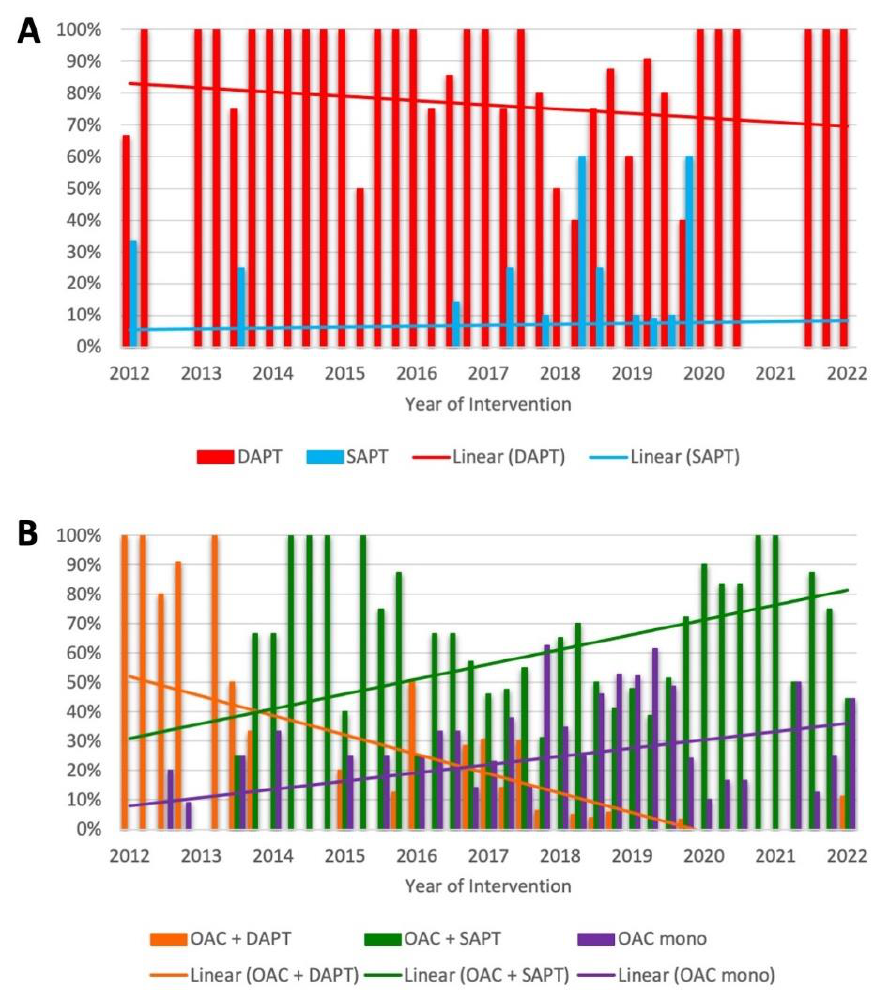
Figure 3. Trends in postprocedural antithrombotic regimens during the study period in patients without (A) and with (B) an indication for oral anticoagulation. ( A ) Quarterly plot with linear trend line of postprocedural prescription of single antiplatelet therapy (SAPT, blue) and dual antiplatelet therapy (DAPT, red). The percentages refer to all patients without indication for oral anticoagulation (OAC, 160/609). Comparison of prescriptions in first and second half of the study period: SAPT: 7.1% vs. 14.5%, p = 0.1; DAPT: 86.9% vs. 77.6%, p = 0.1. ( B ) Quarterly plot with linear trend line of postprocedural prescription of an oral anticoagulant (OAC mono, purple), a combination of OAC and SAPT (green) and a combination of OAC and DAPT (purple). Percentages refer to all patients with indication for OAC (449/609). Comparison of prescriptions in first and second half of the study period: OAC mono: 23.1% vs. 40.0%, p = 0.0001; OAC + SAPT: 51.8% vs. 58.0%, p = 0.2; OAC + DAPT: 25.1% vs. 2%, p < 0.0001.